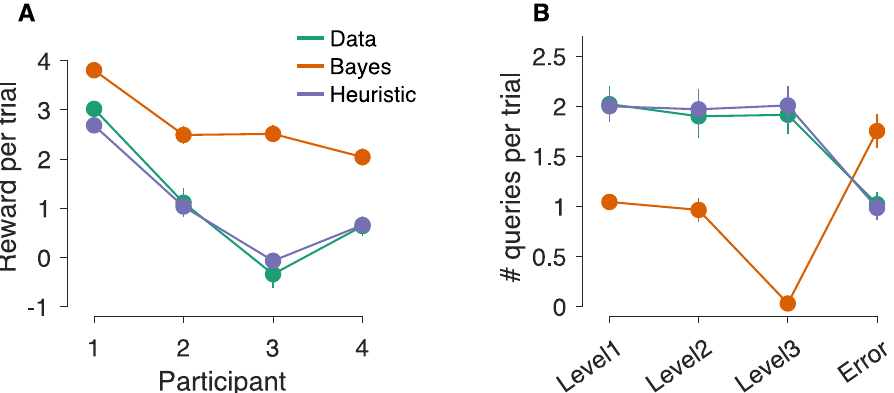
Fig 6. Comparison of average reward and number of queries between data and models. (A) Average reward per trial obtained by the participants, the Bayesian model and the heuristic model. Error bars indicate s.e.m. across trials. (B) Average number of queries per level and of errors at leaf nodes. The averages were first calculated per participant and then across participants. Error bars indicate s.e.m. across participants. The predictions of the Bayesian model (Heuristic model) are based on 2,000 (50,000) simulated trials per